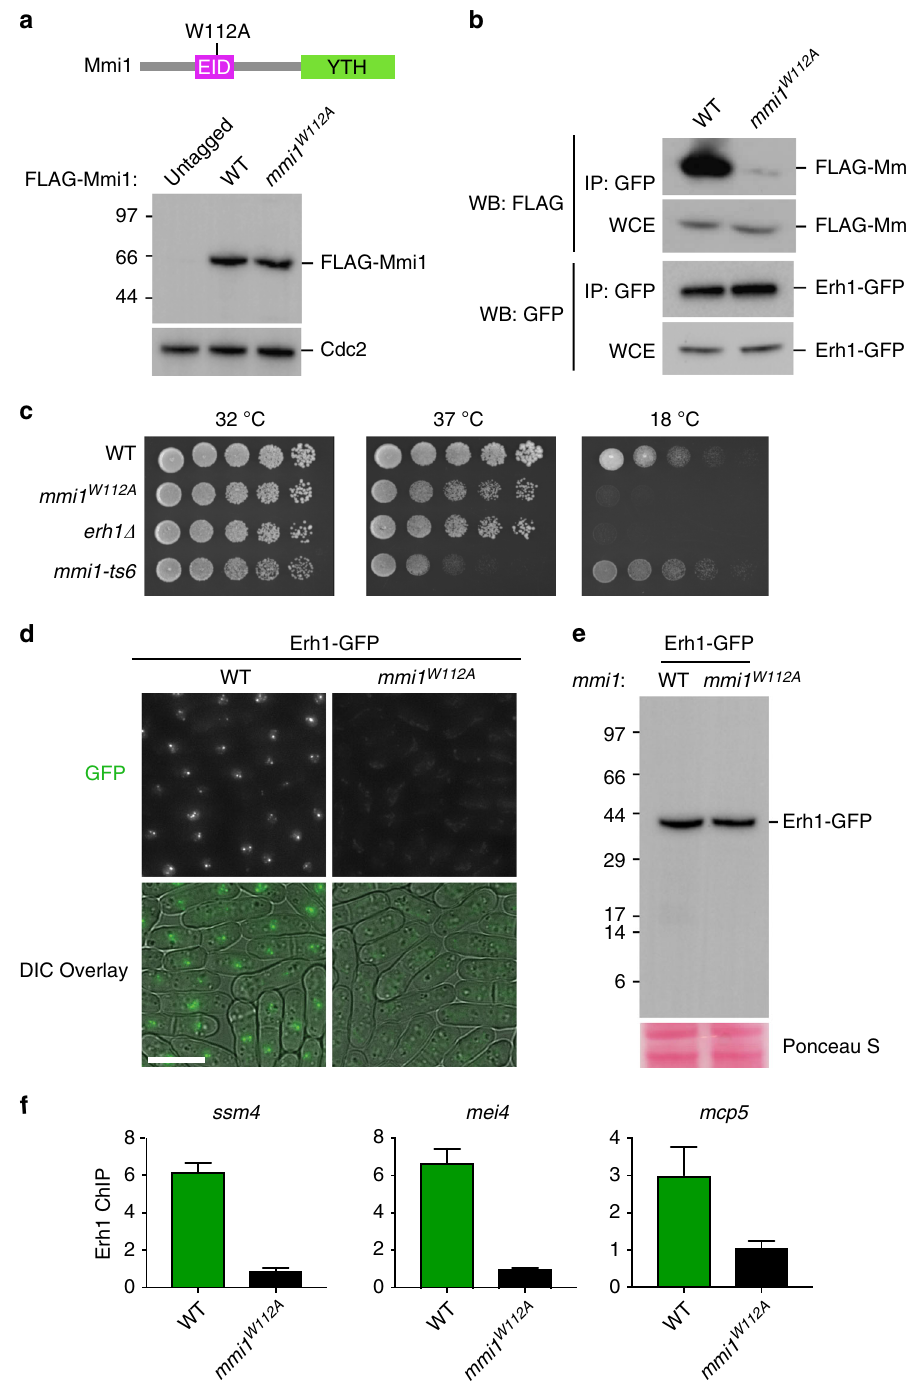
Fig. 4 Mmi1 W112A perturbs EMC functions in vivo. a Western blot analysis of FLAG-Mmi1 WT and FLAG-Mmi1 W112A protein expression levels. Cdc2 serves as loading control. Also shown is a linear schematic of mmi1 W112A mutant. Source data are provided as a Source Data fi le. b Coimmunoprecipitation of